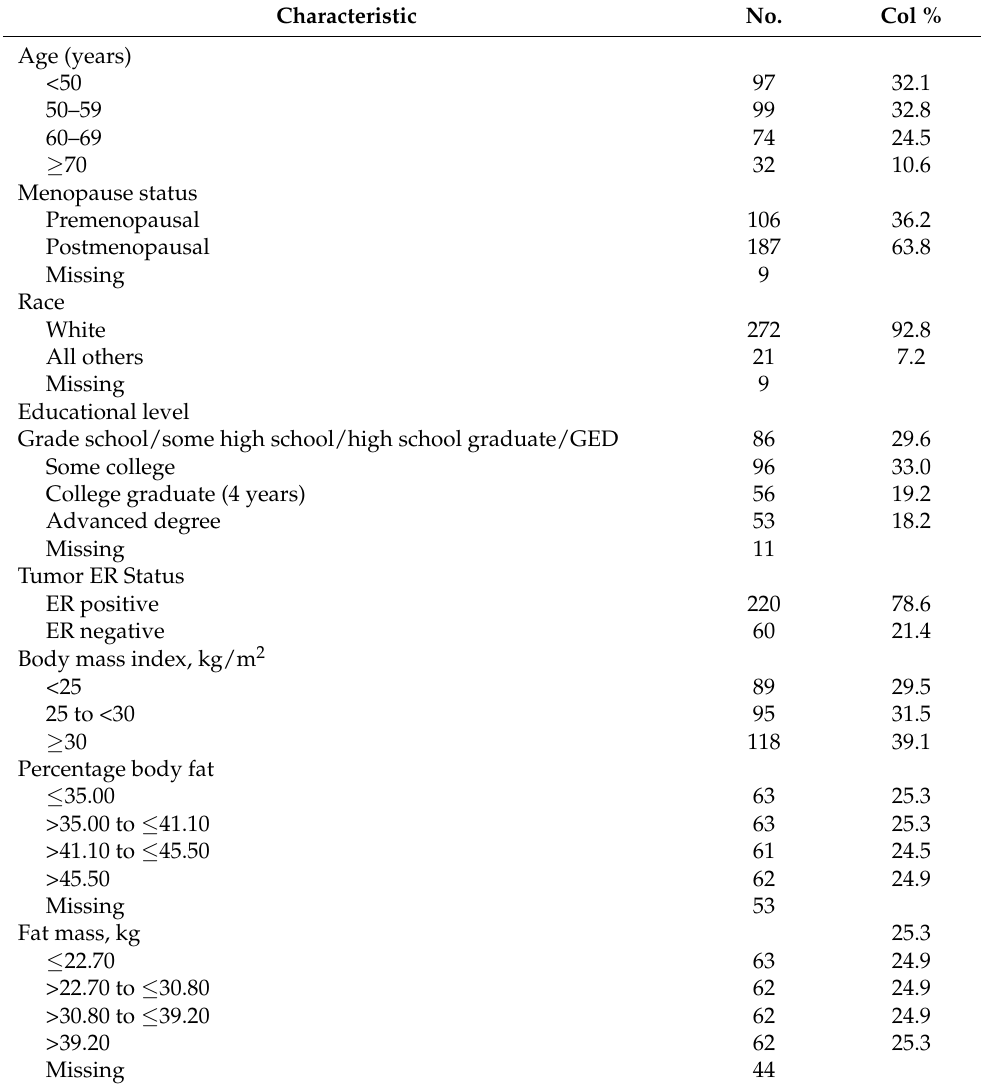
Table 1. Demographic and clinical characteristics of 302 included study patients. Characteristic No. Col